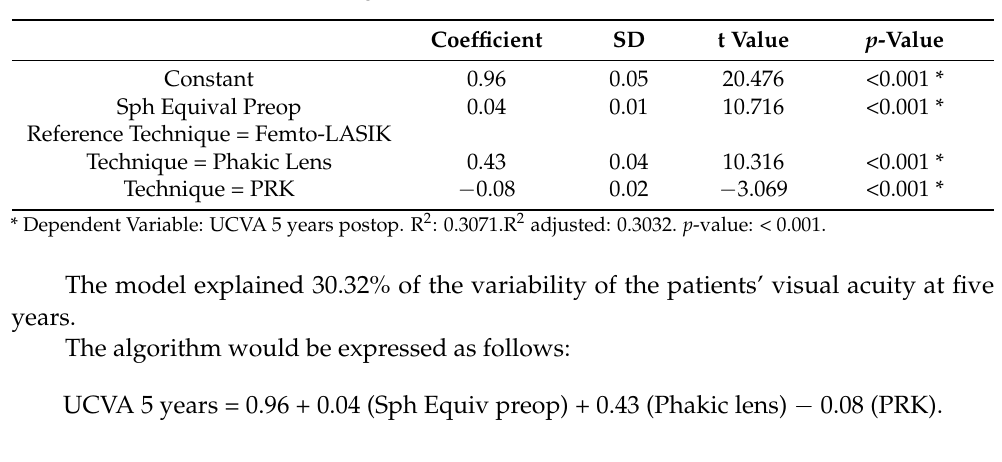
Table 5. Coefficients of the linear regression